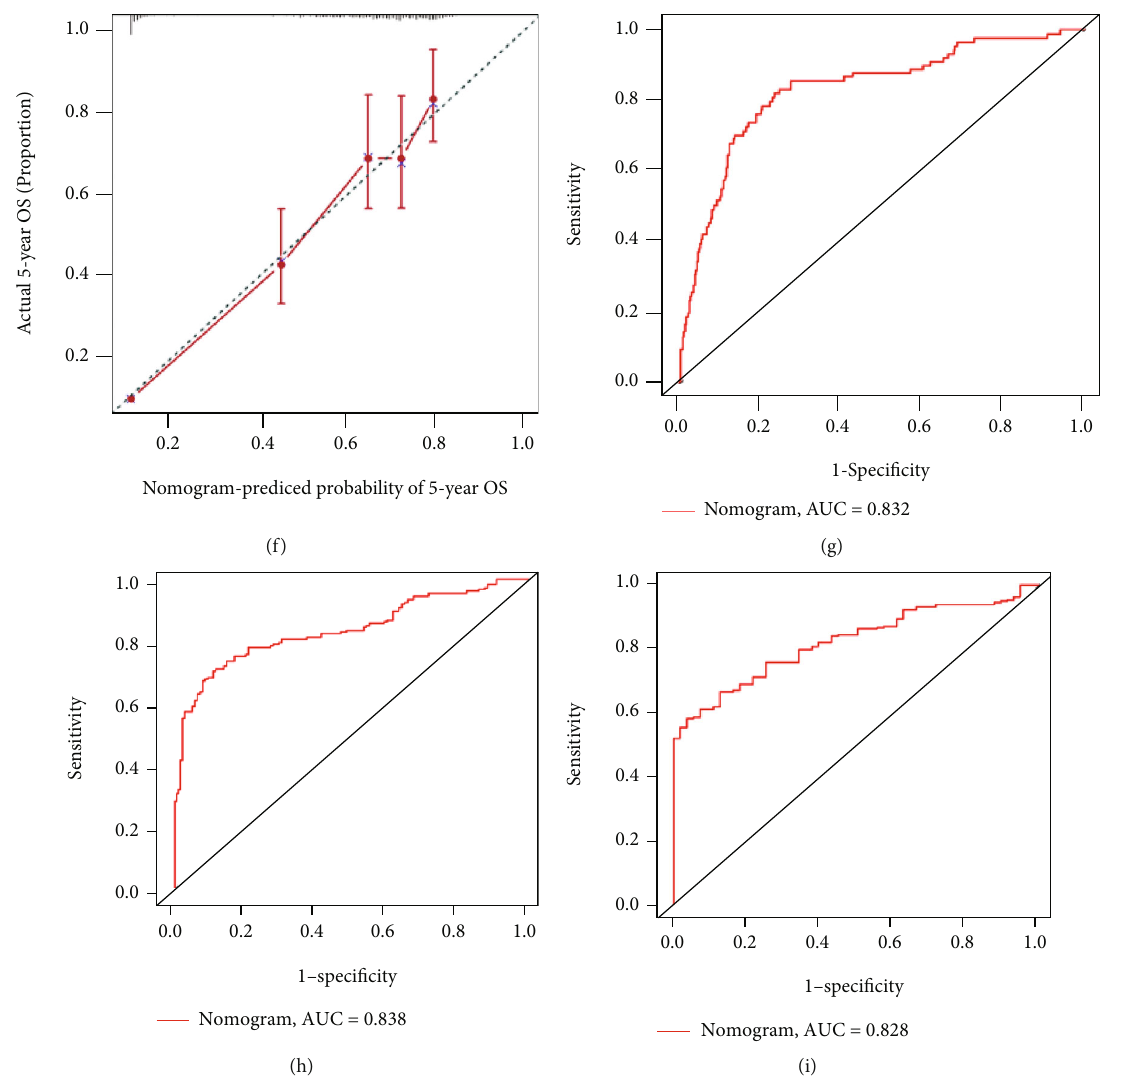
Figure 7: The nomogram for prognostic probability prediction in TCGA database. (a) Univariate and (b) multivariate Cox regression analyses for the IRRG signature and clinical factors. (c) Construction of the nomogram for predicting survival probability for glioma patients at 1, 3, and 5 years. (d – f) The calibration curves for the nomogram at 1-, 3-, and 5-year survival. (g – i) Time-dependent receiver operating characteristic (ROC) curves for the nomogram for predicting the 1-, 3-, and 5-year OS. ∗∗∗ P < 0 : 001